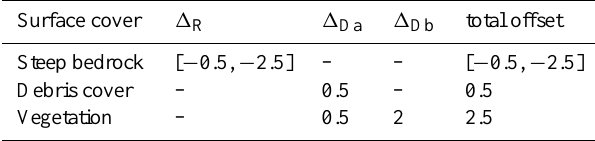
Table 4. Temperature offsets ( ◦ C) that were applied to the different surface types. A positive sign means a positive temperature offset is applied, which results in a more pessimistic permafrost estimate. A negative sign means a more optimistic permafrost